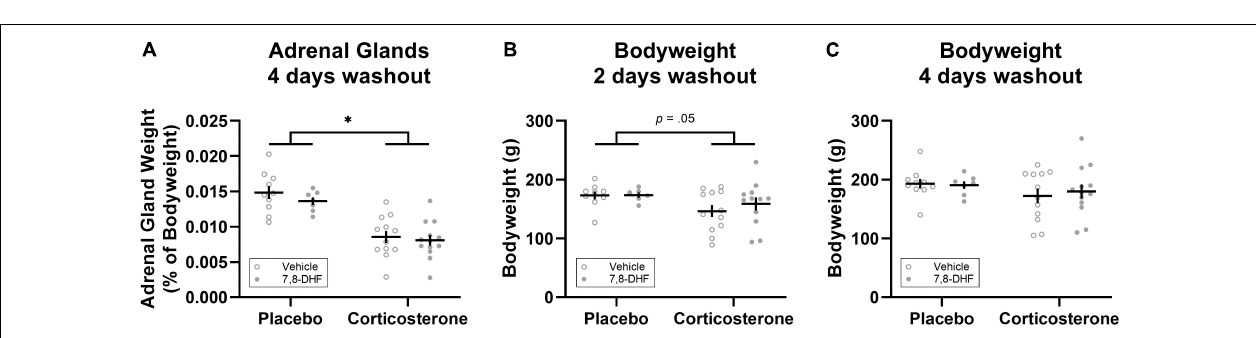
FIGURE 2 | 7,8-DHF combined with extinction training does not affect CS-elicited freezing during extinction training or tests of extinction retention and renewal in adolescent rats exposed to corticosterone. Data included in Analysis 2 are represented by mean ( ± SEM) levels of CS-elicited freezing at Conditioning (A) and Extinction (B) . CS-elicited freezing data at the Extinction Retention (C) and Renewal (D) tests are shown as individual dot plots with mean ( ± SEM). Group sizes were n = 16 for vehicle and n = 24 for 7,8-DHF.